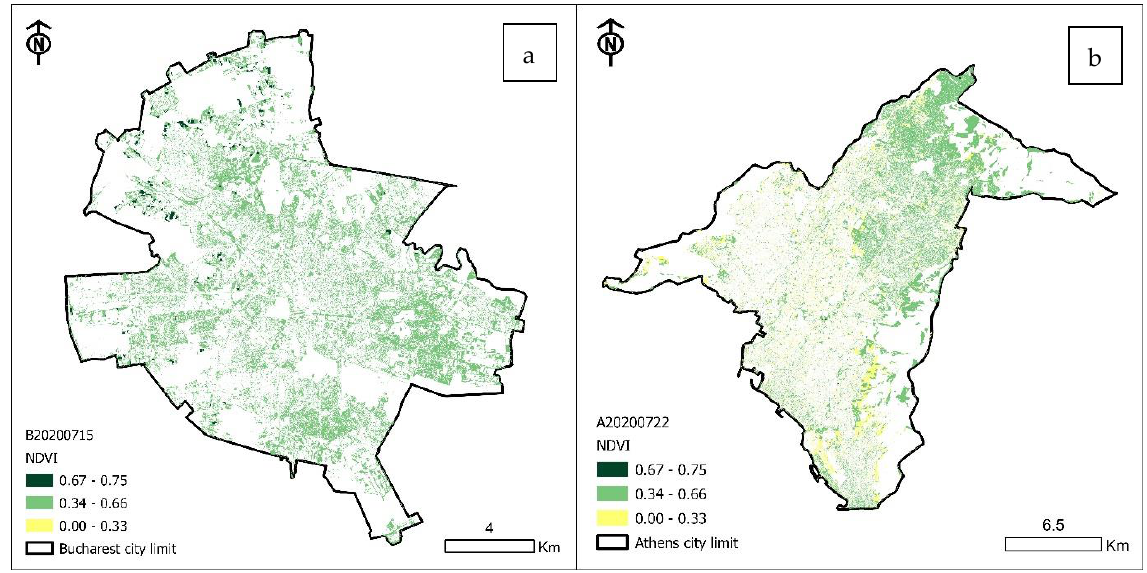
Figure 4. NDVI distribution of small urban green areas for July 2020 in Bucharest ( a ) and Athens ( b ).